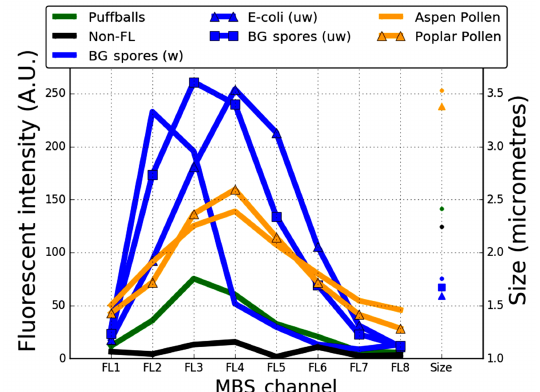
Figure 6. Average fluorescent intensity given in arbitrary units (AU) for the eight fluorescent channels and the size given in micrometres for the laboratory data. The fluorescent signatures for the paper mul- berry sample are not included in the figure as the particles are much larger and more fluorescent than the remaining samples and their inclusion would cause the graph to be uninterpretable.